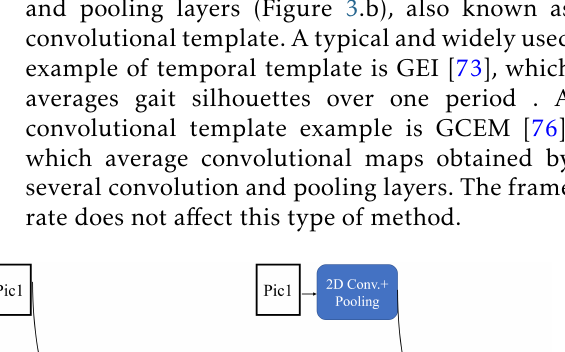
Table 2. EXISTING DATASETS